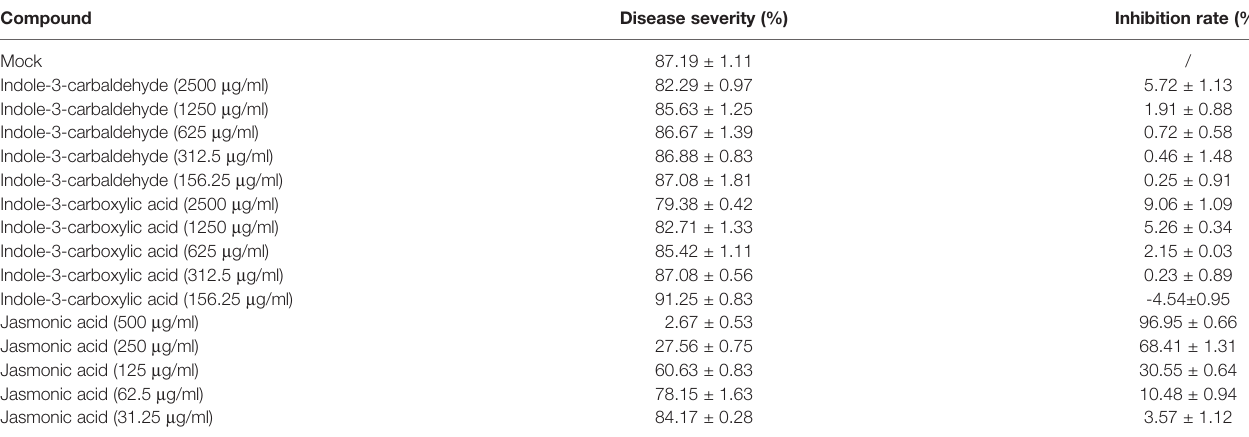
TABLE 2 | The activities of indole-3-carbaldehyde, indole-3-carboxylic acid, and jasmonic acid against wheat powdery mildew in the laboratory. Compound